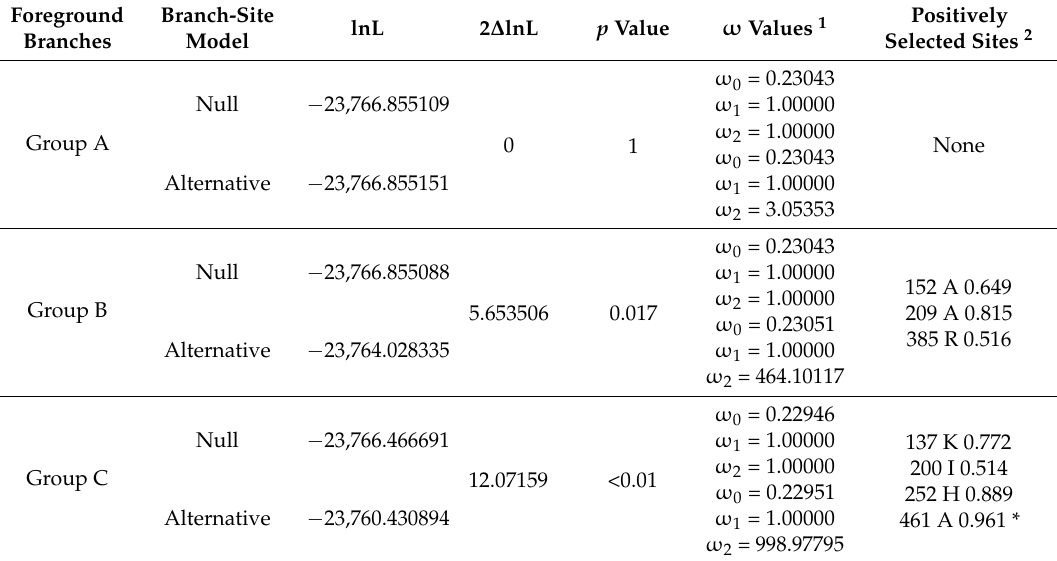
Table 2. Selective pressure analyses of SABATH genes in S. miltiorrhiza by branch-site